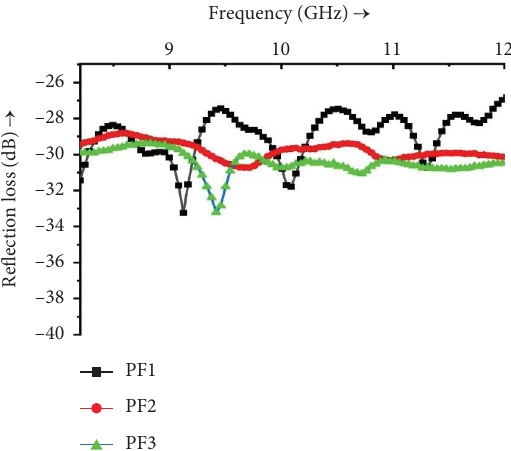
Figure 18: Absorption characteristics of the prepared PF1, PF2, and PF3 at X-band (8.2–12.4)